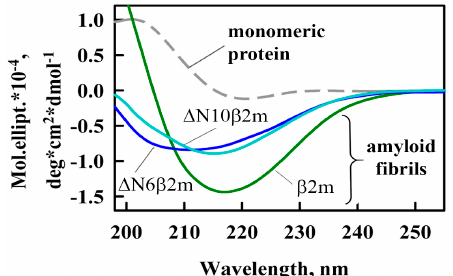
Figure 2. Far ‐ UV CD spectra of β 2m monomer (dashed gray curve) and amyloid fibrils formed from β 2m (green curve), ∆ N6 β 2m (blue curve) and ∆ N10 β 2m (cyan curve).